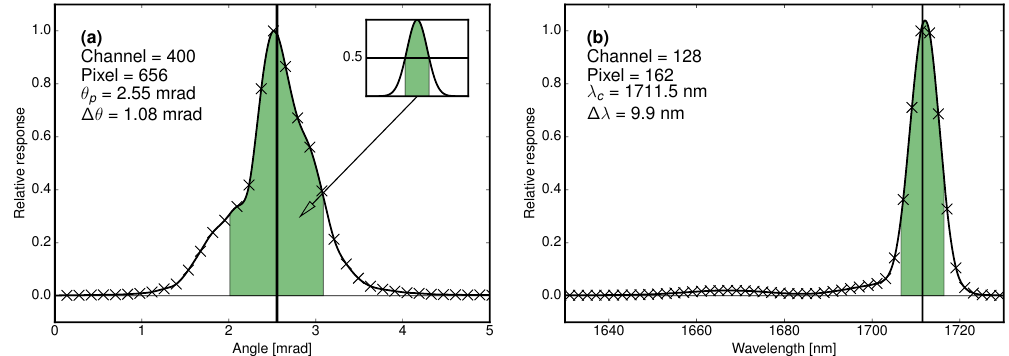
Figure 16. (a) LSF of spectral channel 400 for spatial pixel 656 of the VNIR sensor. The vertical line denotes the median viewing angle θ c , the width of the filled area the angular resolution (cid:49)θ . (b) SRF of spectral channel 128 for spatial pixel 162 of the SWIR sensor. The vertical line denotes the median wavelength λ c , the width of the filled area the wavelength bandwidth (cid:49)λ . For both plots the crosses are the measurements, and the curve is a spline fitted to these data points.